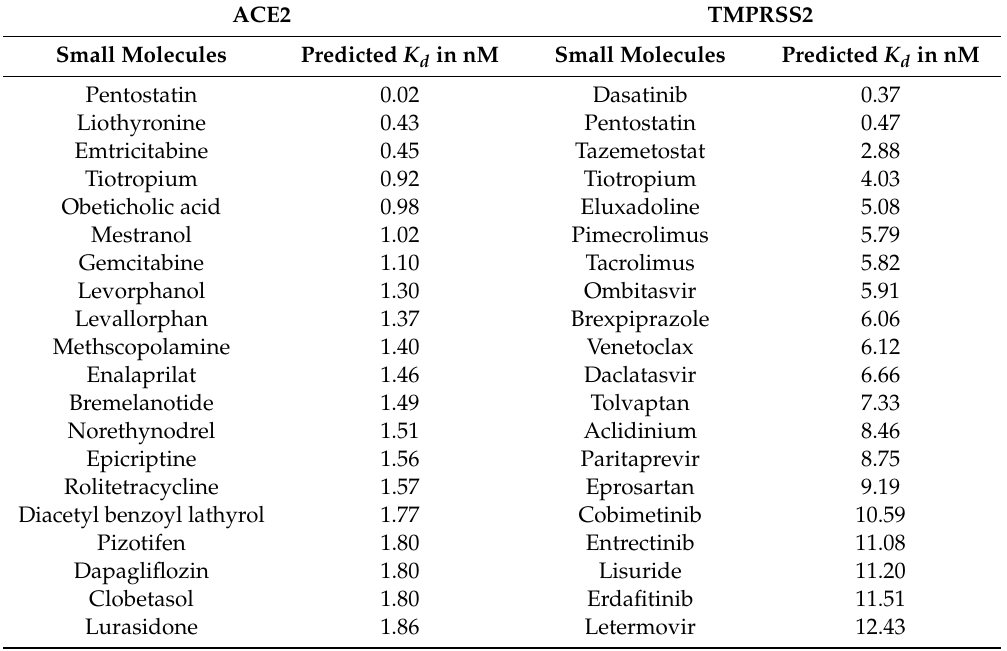
Table 1. Top 20 predicted drugs identified by MT-DTI against ACE2 (NCBI Reference